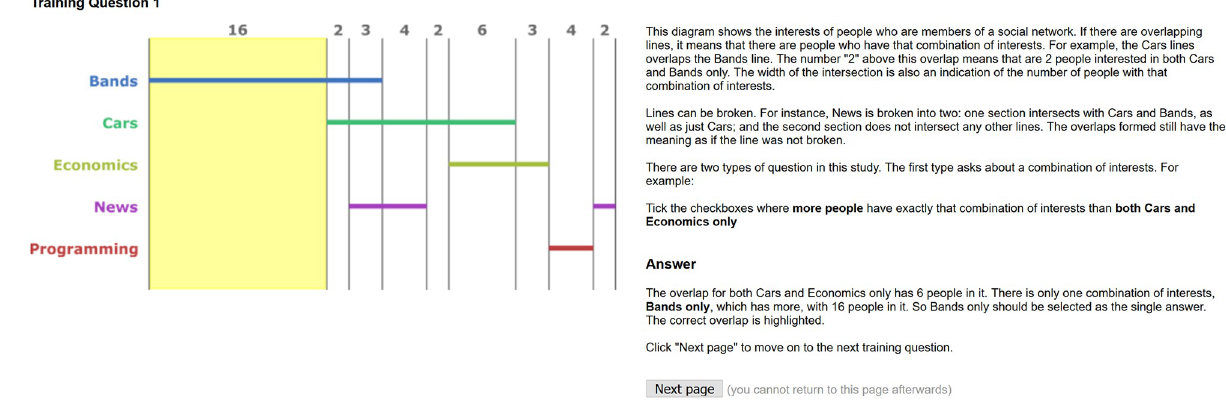
Fig 6. The first explanation